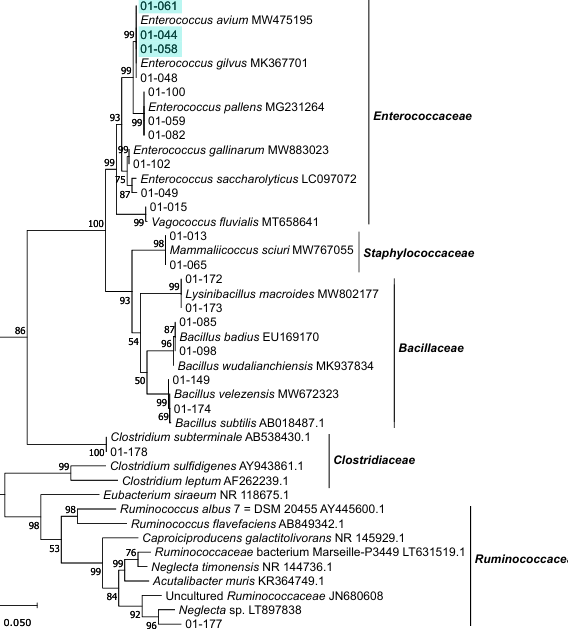
Figure 6. Unrooted maximum-likelihood tree of isolates belonging to the phylum Firmicutes , shown along with the closest related type strains and other relevant cultured and uncultured bacte- ria. Phylogenetic analysis is based on the unambiguous alignment (1306 sequence positions) of 16S rRNA gene sequences. GenBank accession numbers are included. Numbers at nodes indicate bootstrap values, based on 1000 replications. Identical isolates based on fingerprinting results (see Supplementary Figure S1) are marked with the same